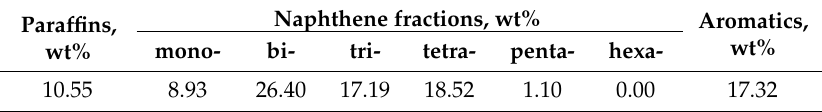
Figure 1. Gas chromatography-mass spectrometry (GC/MS) spectrum of the maltene part of crude oil sample from the North Sea. Table 1. The content of main fractions in the maltene part of the North Sea crude oil.